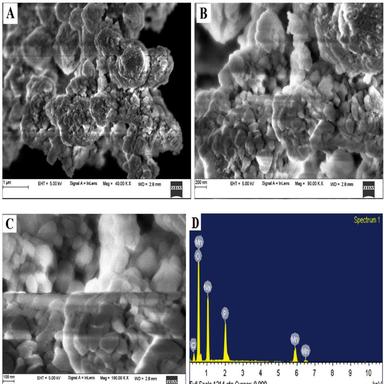
SEM images of the synthesized Na3MnCO3PO4 at different magnifications (A) 1 μm, (B) 200 nm (C) 100 nm and (D) the EDX spectrum of Na3MnCO3PO4.